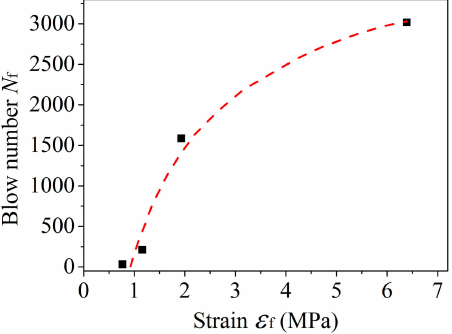
Figure 14. Relation between N f and ε f